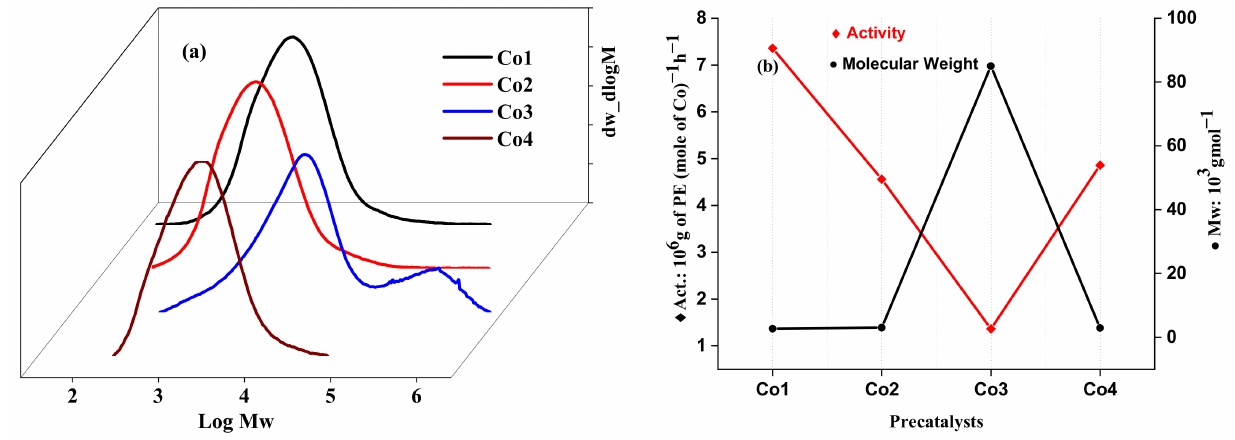
Figure 9. GPC curves of the obtained polyethylene ( a ); activity and M w for different precatalysts at the optimized reaction conditions ( b ) for the Co1 – Co4 /MAO system (Table 4, entries